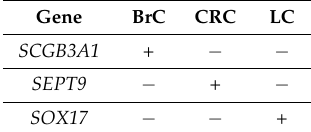
Table 3. Methylated gene promoter combinations for BrC, CRC and LC discrimination using the “CancerType” panel.